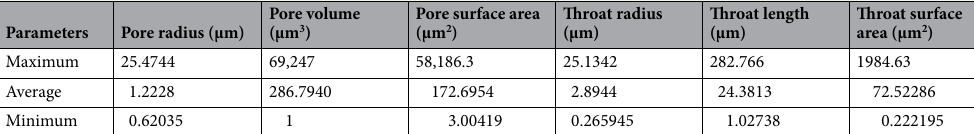
Table 10. Quantitative parameter statistics of pore network model in nylon-rubber